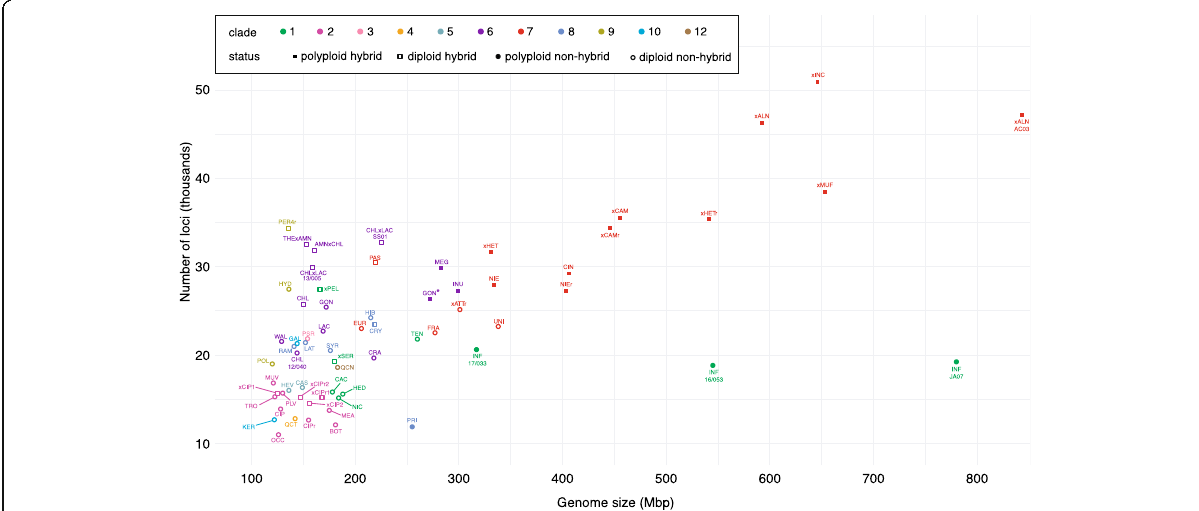
Fig. 3 Average number of loci and genome size of Phytophthora species. The colour refers to the clade of the species while the shape refers to the hybrid status of the species. Isolates that deviate significantly from other isolates of their species in terms of average number of loci and/or genome size are shown separately, together with their isolate code. The second P. gonapodyides point (marked with an asterisk) refers to isolates 05/025, 06/001, 07/004 and 07/007. For isolates with multiple nuclear genome sizes we used the one corresponding to the predominant flow cytometry fluorescence peak (for additional peaks, see Table